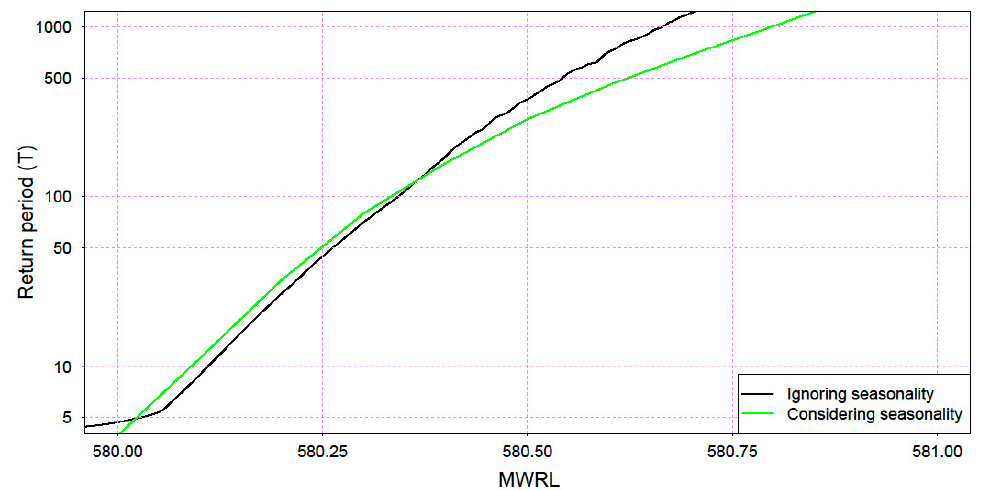
Figure 14. Plotting positions of MWRL derived from synthetic hydrograph dam routing.